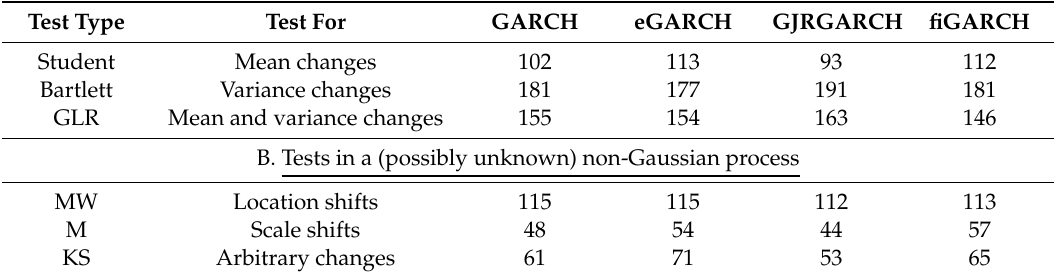
Table 5. Number of breakpoints detected using di ff erent test